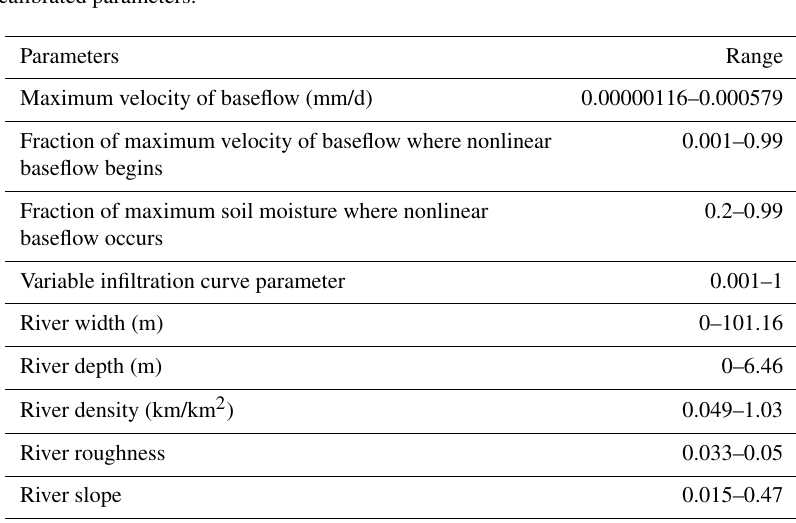
Table 3. Descriptions of calibrated